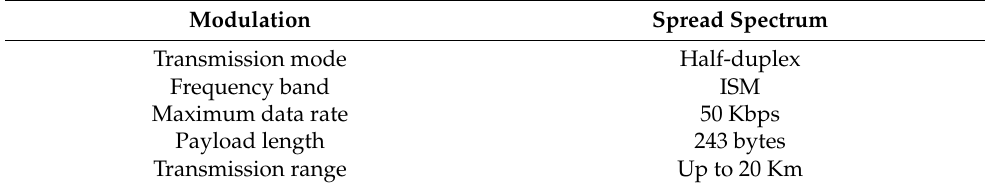
Table 5. Summary of LoRa